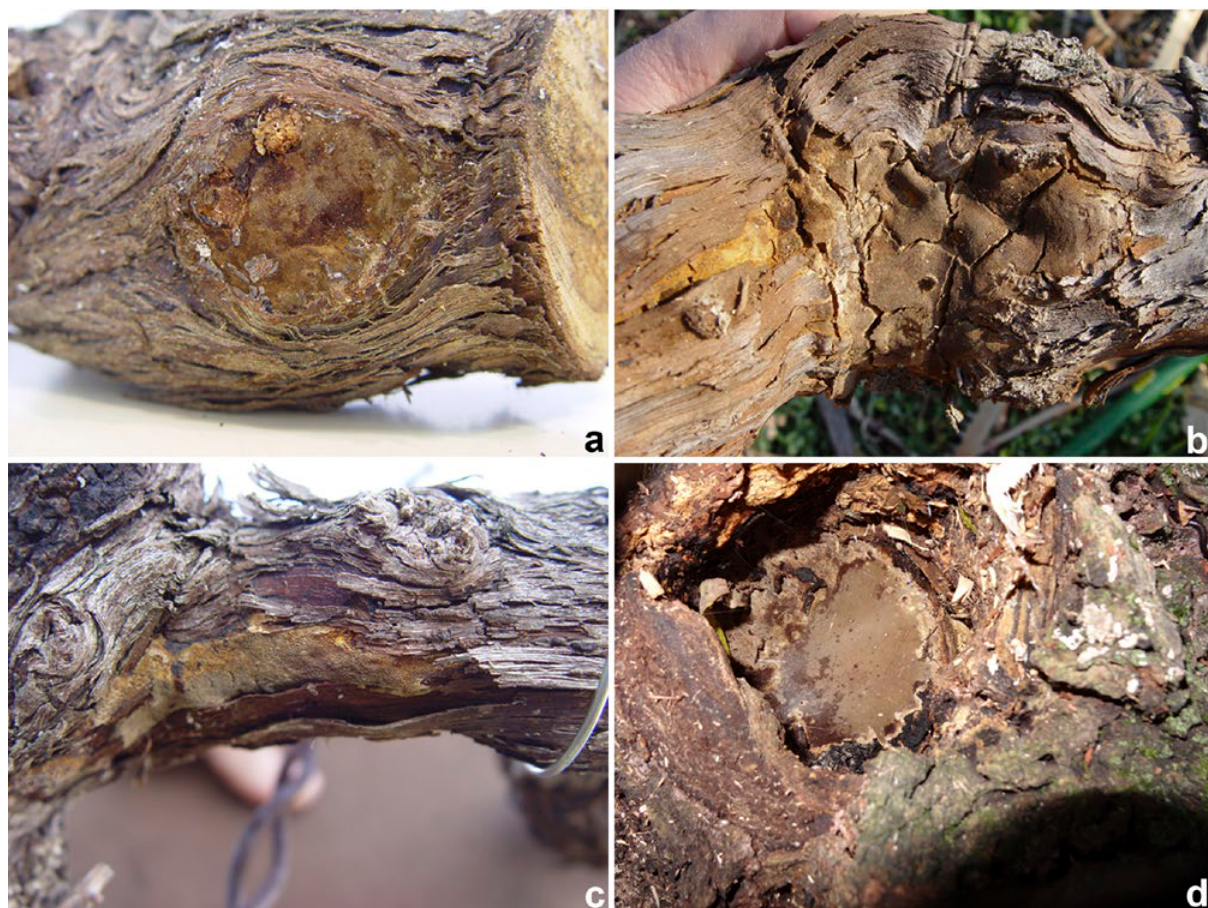
Figure 4. Fruit bodies of Hymenochaetales species associated with esca diseased grapevines in South Africa. a. Fruit body of Fomitiporia capensis on Vitis vinifera cv. Chenin blanc. b. Fruit body of Phellinus resupinatus on cv. Sultana. c. Fruit body of Fomitiporella sp. on cv. Pinotage. d. Fruit body of Inonotus setuloso-croceus which was found on Salix